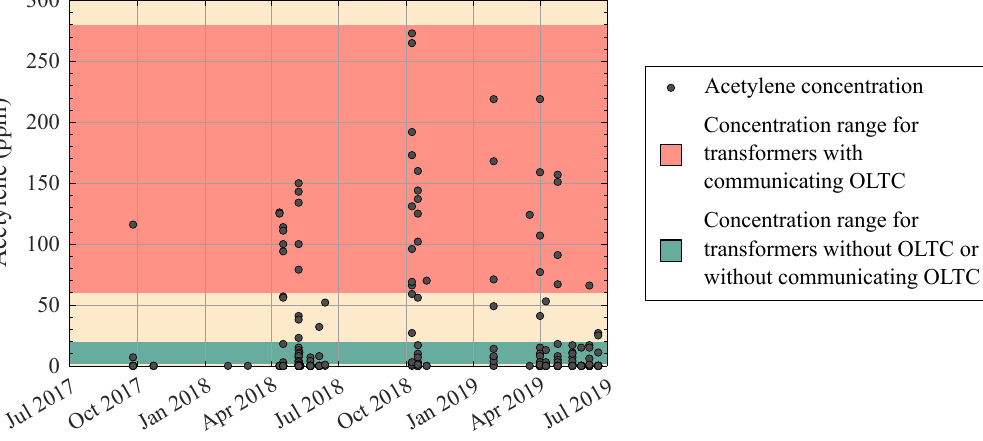
Figure 7. Acetylene concentration